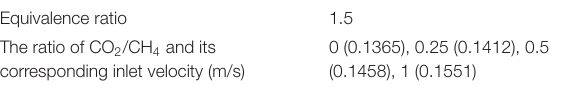
TABLE 2 | Simulation cases carried out in this